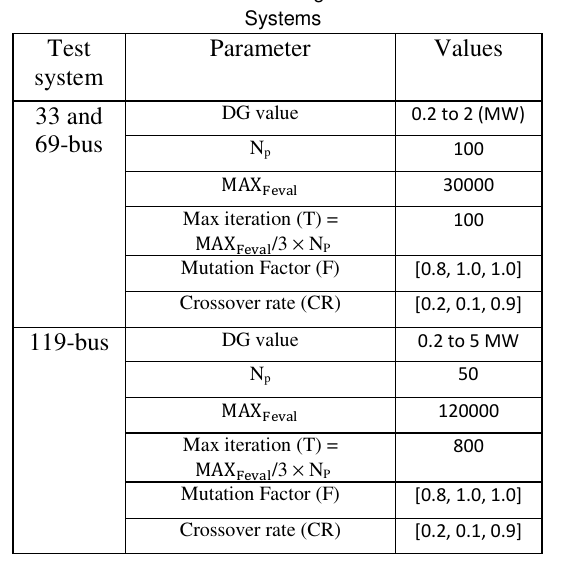
test systems are shown in Table 2. Table 2: Parameters of C 2 oDE Algorithm for The IEEE Test